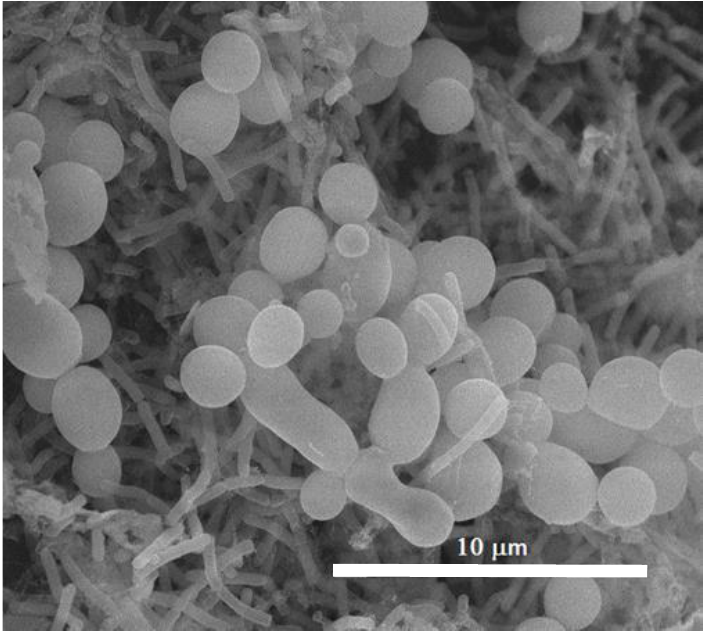
Figure 2. SEM observation of the 48 h dual species biofilm of C. albicans and K. pneumoniae . Scale bar = 10 µm.